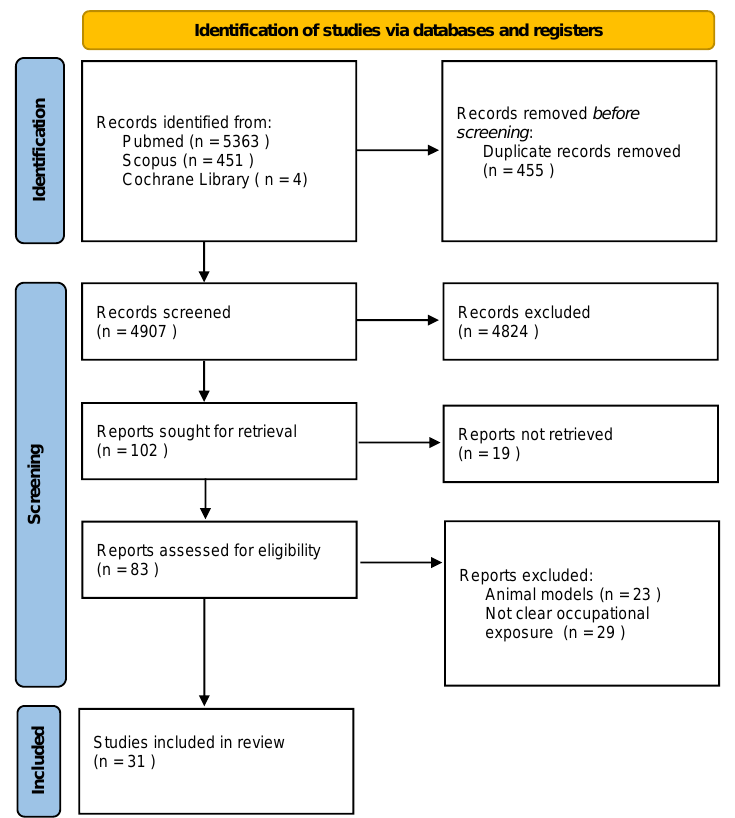
Figure 1. PRISMA 2020 Flow diagram for systematic reviews.